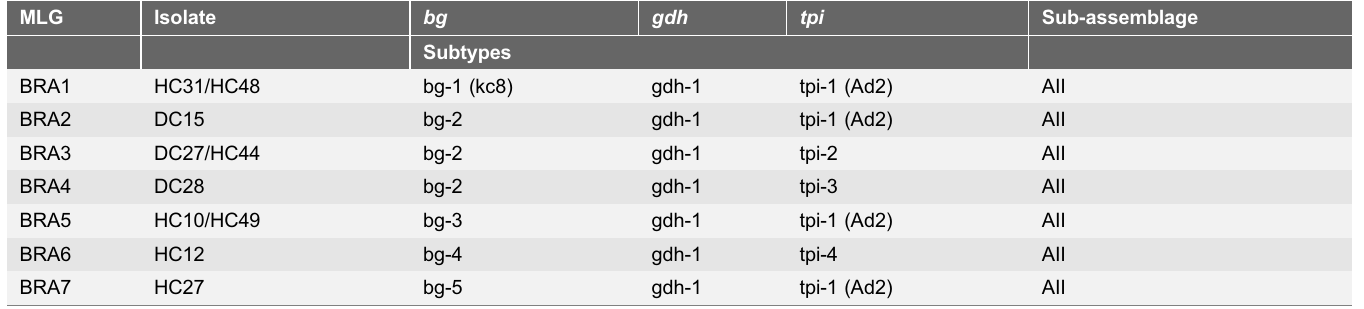
Table 5. Multilocus genotypes (MLGs) in G. duodenalis assemblage A isolates.